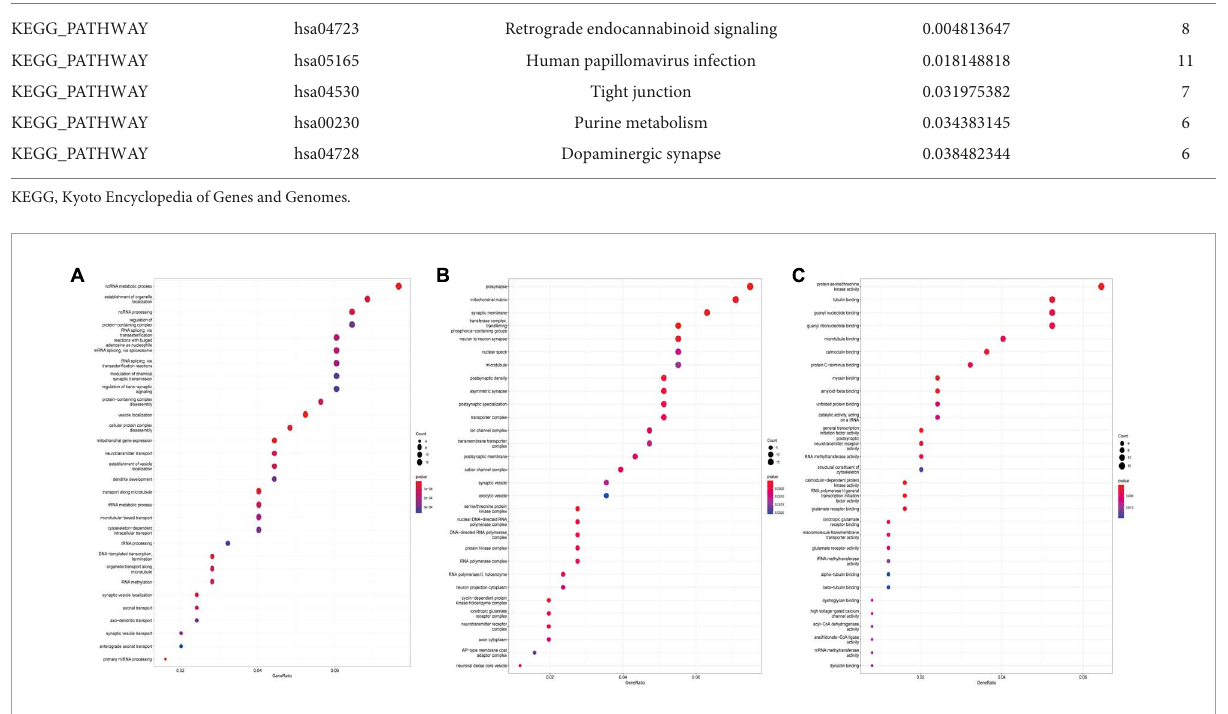
cell survival and DNA repair (PRPF19; score = 2,809),